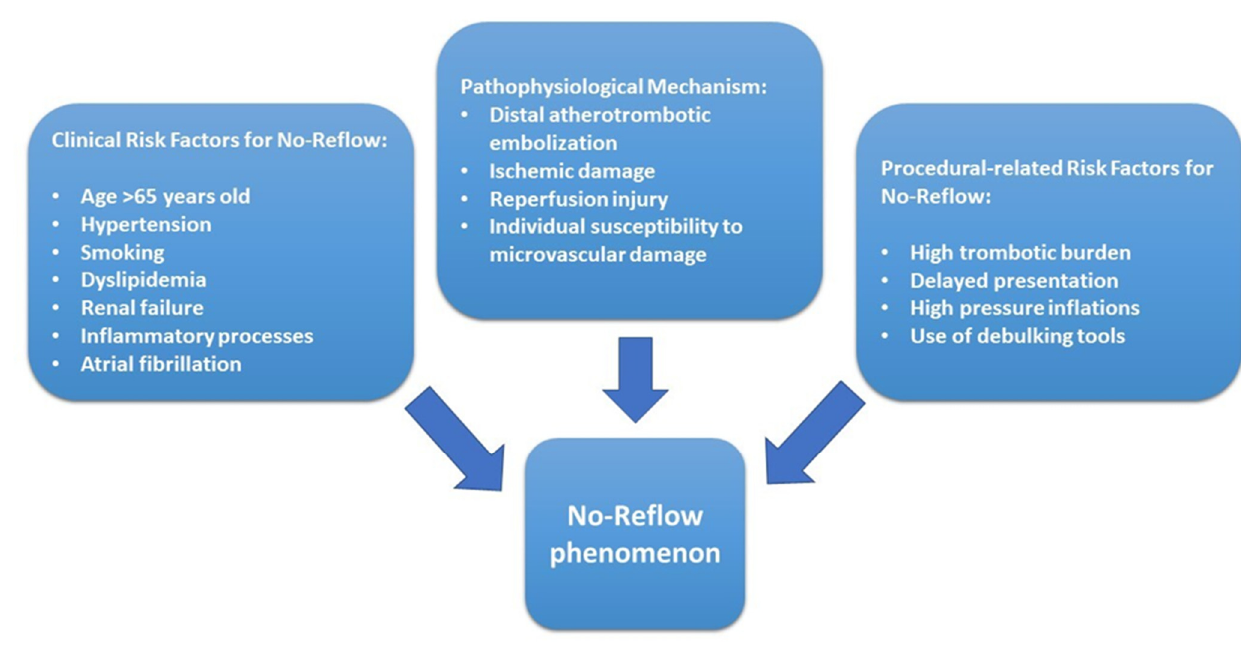
Figure 1. Summary of all the different factors involved in the genesis of the NR phenomenon.